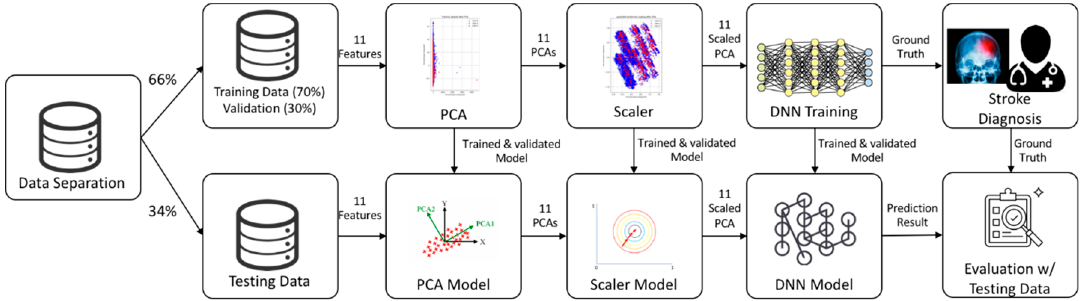
Figure 2. The architecture of the deep neural network (DNN) / scaled principal component analysis (PCA) approach.